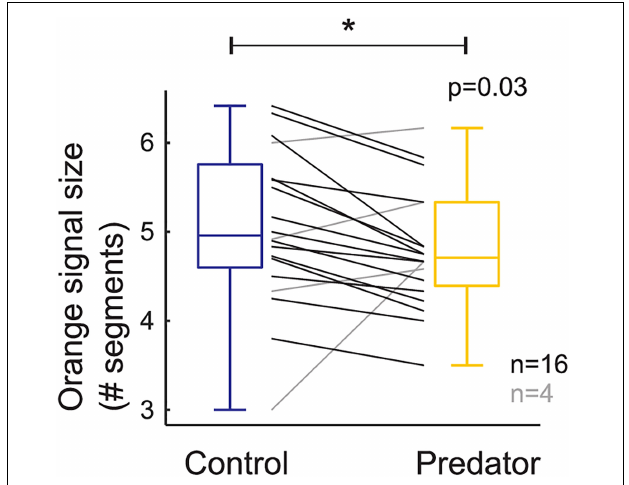
FIGURE 2 | Larval orange signal size based on raw data (i.e., each black and gray line represents a family). Boxplots show the mean values on control and predator treatment. * means significance.